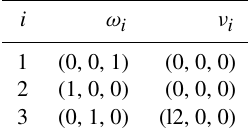
Table 2. The coordinates of the spiral axes of the configuration. Table 3. The coordinates of the spiral axes of the upper limb.